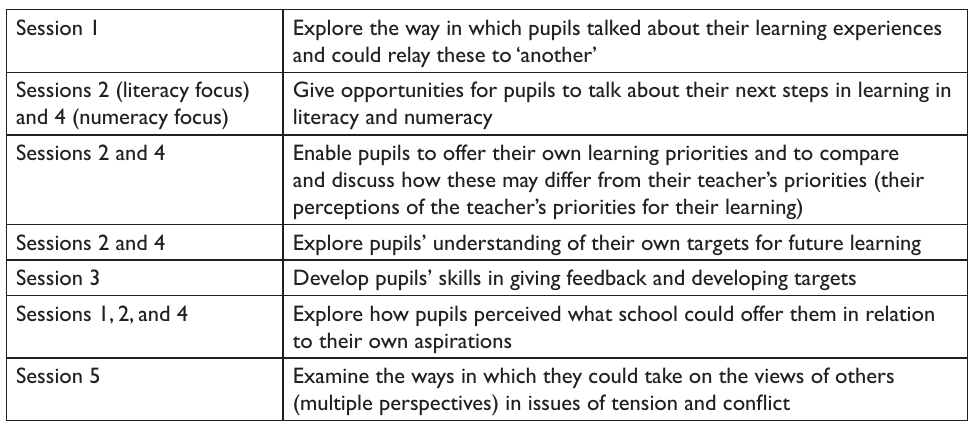
Table 1: Themes and ideas in one-to-one